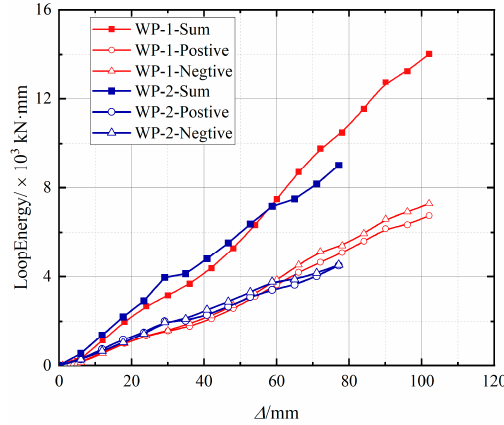
Figure 16. The loop energy of the specimen.